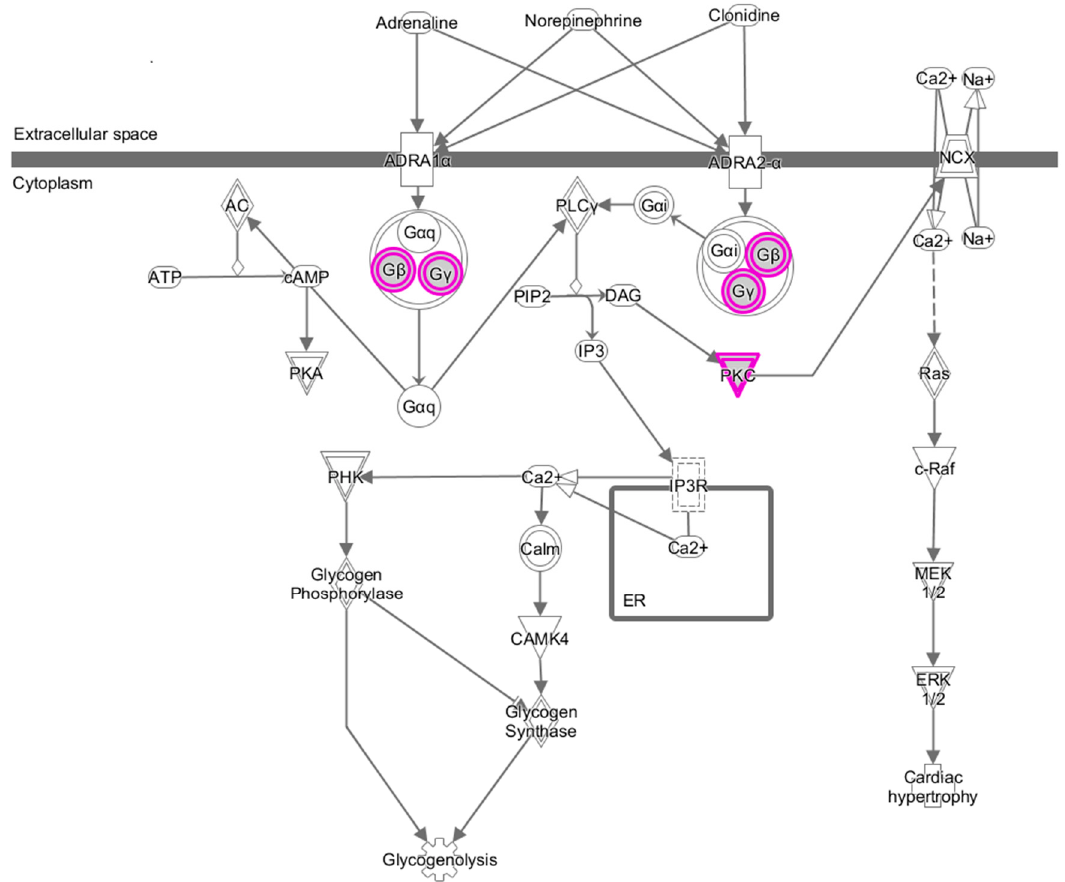
Figure 2. An illustration depicting detailed alpha-adrenergic receptor (ADR) signaling pathways. Purple circles represent the genes in which one allele deletion is more common in patients with atrial fibrillation related thromboembolic stroke compared to controls. AC , 3’,5’-cyclic AMP synthetase; ADRA1 α , adrenergic Receptor alpha1a; ADRA2- α , adrenergic receptor, alpha2a; ATP , adenosine 5’-triphosphate; c-Raf , serine/threonine kinase; CAMK4 , calcium/calmodulin-dependent protein kinase IV; cAMP , cyclic-3’,5’-monophosphate; DAG , diacylglycerides; ERK1/2 , p42/p44 MAP kinase; G α i , G protein alpha I subunits; G α q , alpha q polypeptide; G α q-G β -G γ , G protein alpha beta gamma; G β , G-protein beta subunits; G γ , G protein gamma subunits; IP3 , inositol 1,4,5-triphosphate; IP3R , Inositol 1,4,5-triphosphate receptor; NCX , Na+/Ca+ exchanger; PHK , Glycogen phosphorylase kinase; PIP2 , 1-phosphatidyl-1D-myo-inositol 4,5-bisphosphate; PKA , cAMP-dependent protein kinase; PKC , protein kinase C; PLC γ , Phospholipase C gamma.